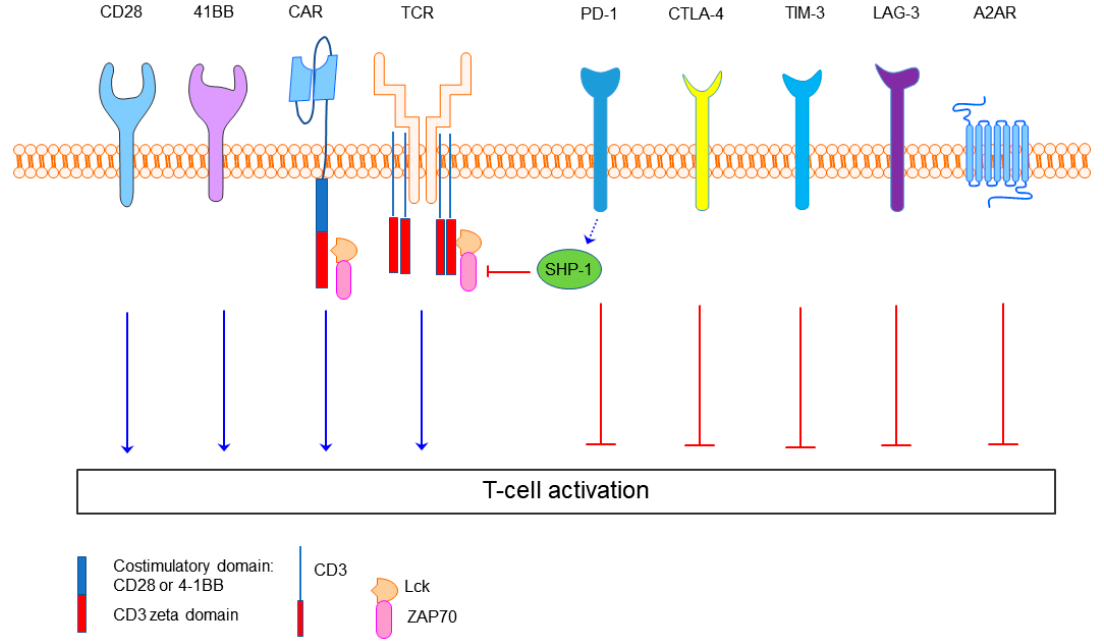
Figure 1. The structure of the second-generation chimeric antigen receptor (CAR) and examples of the immune checkpoints. The second-generation CAR is composed of a single-chain Fv domain (scFv) targeting tumor cells, hinge and transmembrane domains along with the CD28 or 4-1BB, and CD3 zeta co-stimulatory domains. T cell receptor (TCR) kinases like Lck and ZAP70 relay the activation signal of TCR and CAR once antigen dependent receptor clustering has occurred. Inhibitory molecules include Src homology 2 domain-containing protein tyrosine phosphatase 1 (SHP-1) PD-1, CTLA-4, TIM-3, LAG-3 and adenosine 2A receptor (A2AR). SHP-1 is an inhibitory protein tyrosine phosphatase that can dephosphorylate the intracellular domains. PD-1 is a pivotal immune checkpoint receptor involved in T cell exhaustion. CTLA-4 is an immune checkpoint that competes with CD28 for its B7 ligands. TIM-3 is another immune checkpoint which is highly expressed in exhausted T